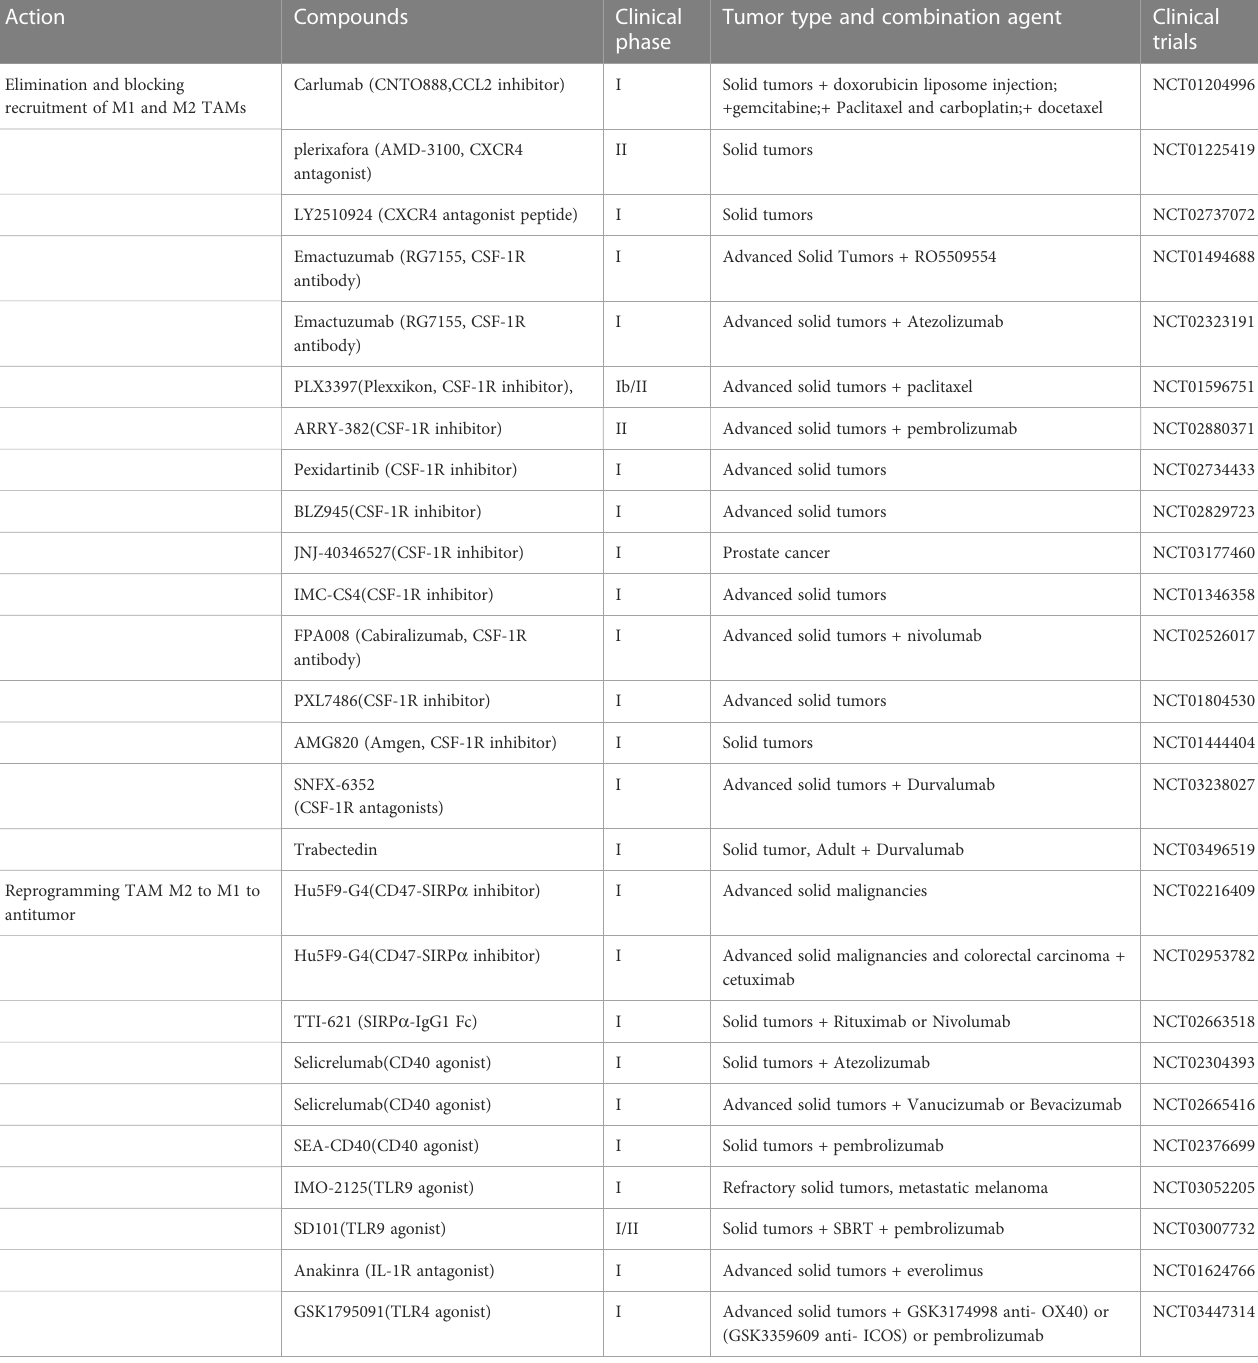
TABLE 1 Clinical trials of solid tumors associate of macrophage-targeting compounds. Action Compounds Clinical